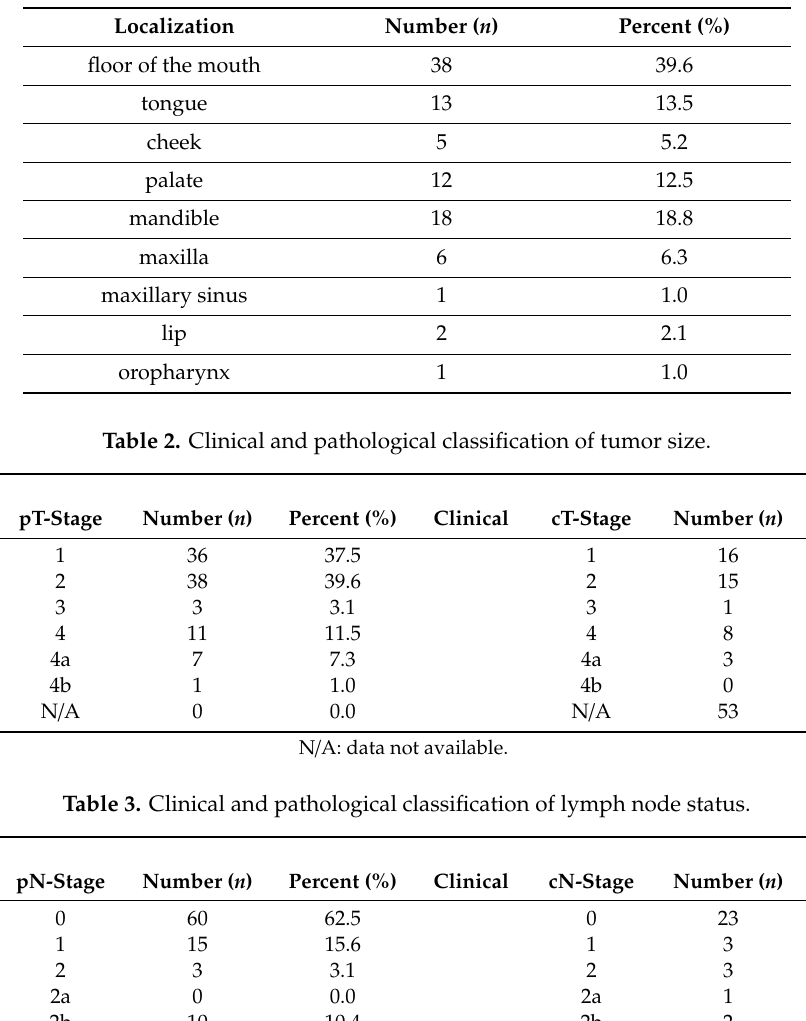
Table 1. Localization of oral squamous cell carcinoma (OSCC).